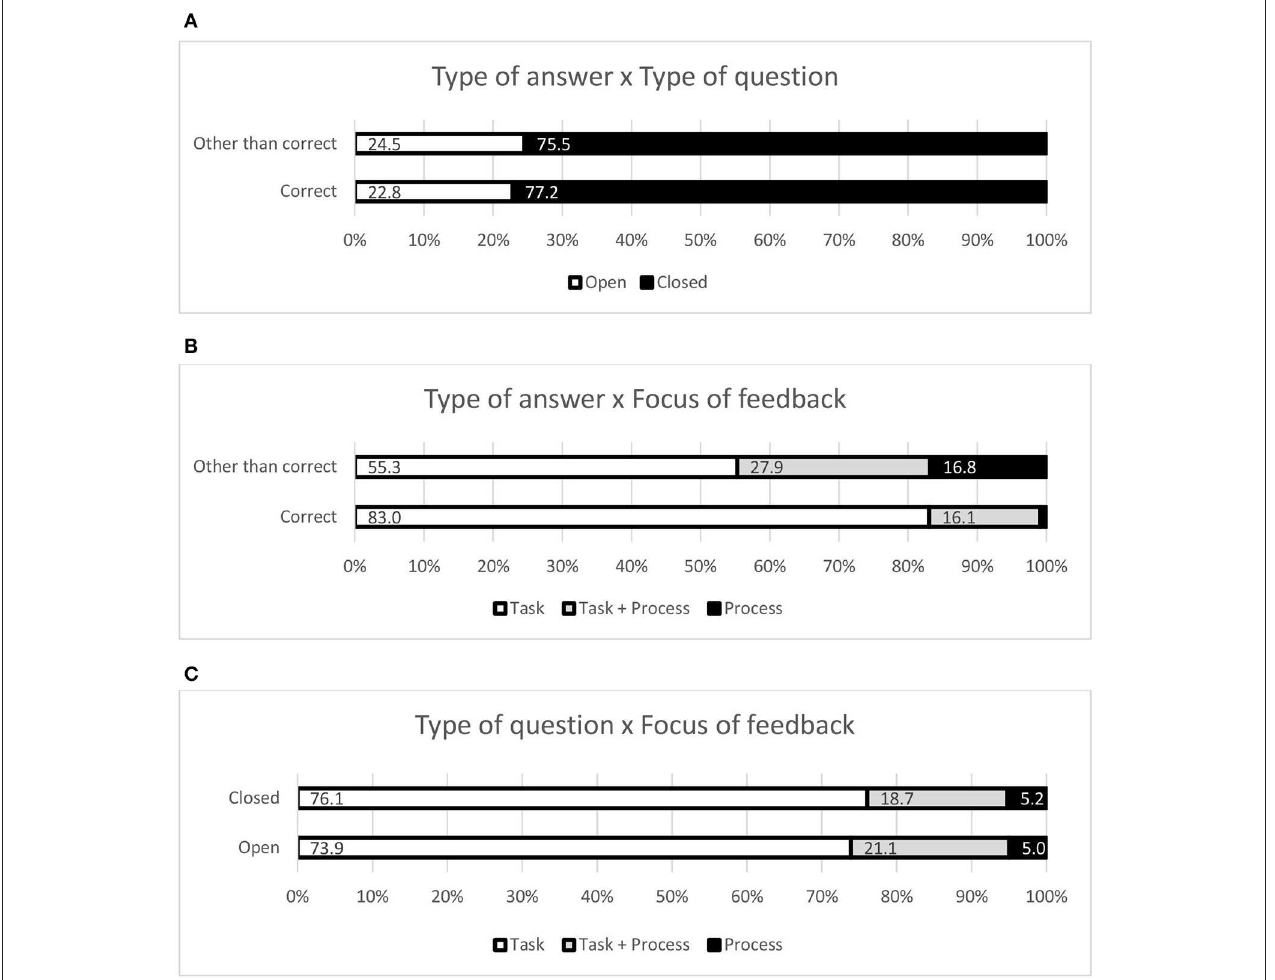
FIGURE 2 | Graphical representation of the association between the Type of answer and the Type of question (A) , between the Type of answer and the Focus of feedback (B) , and between the Type of question and the Focus of feedback (C)